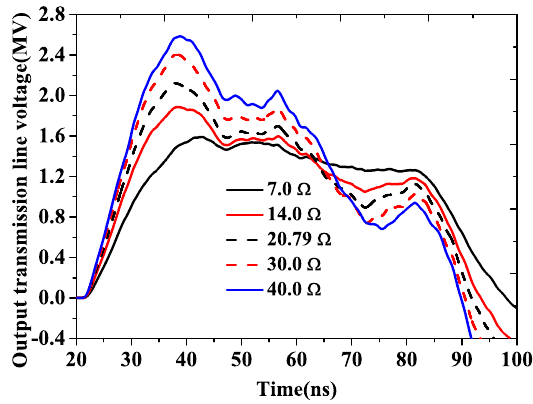
FIG. 11. Output transmission line voltage waveforms with different output transmission line impedance acquired by 2D circuit simulation. The voltage probe is near the ground